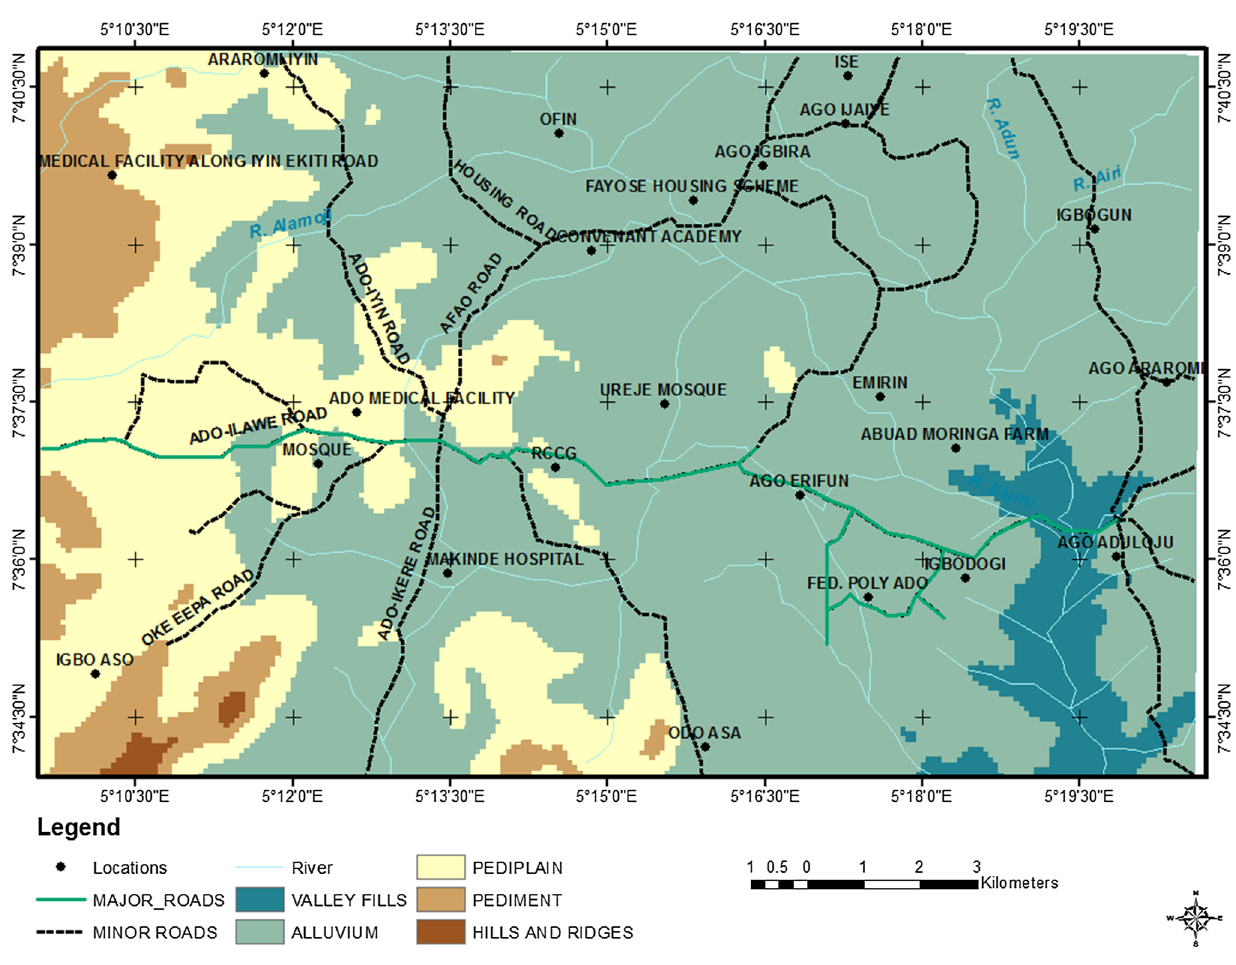
Fig. 7 Hydrogeomorphological map of the study area